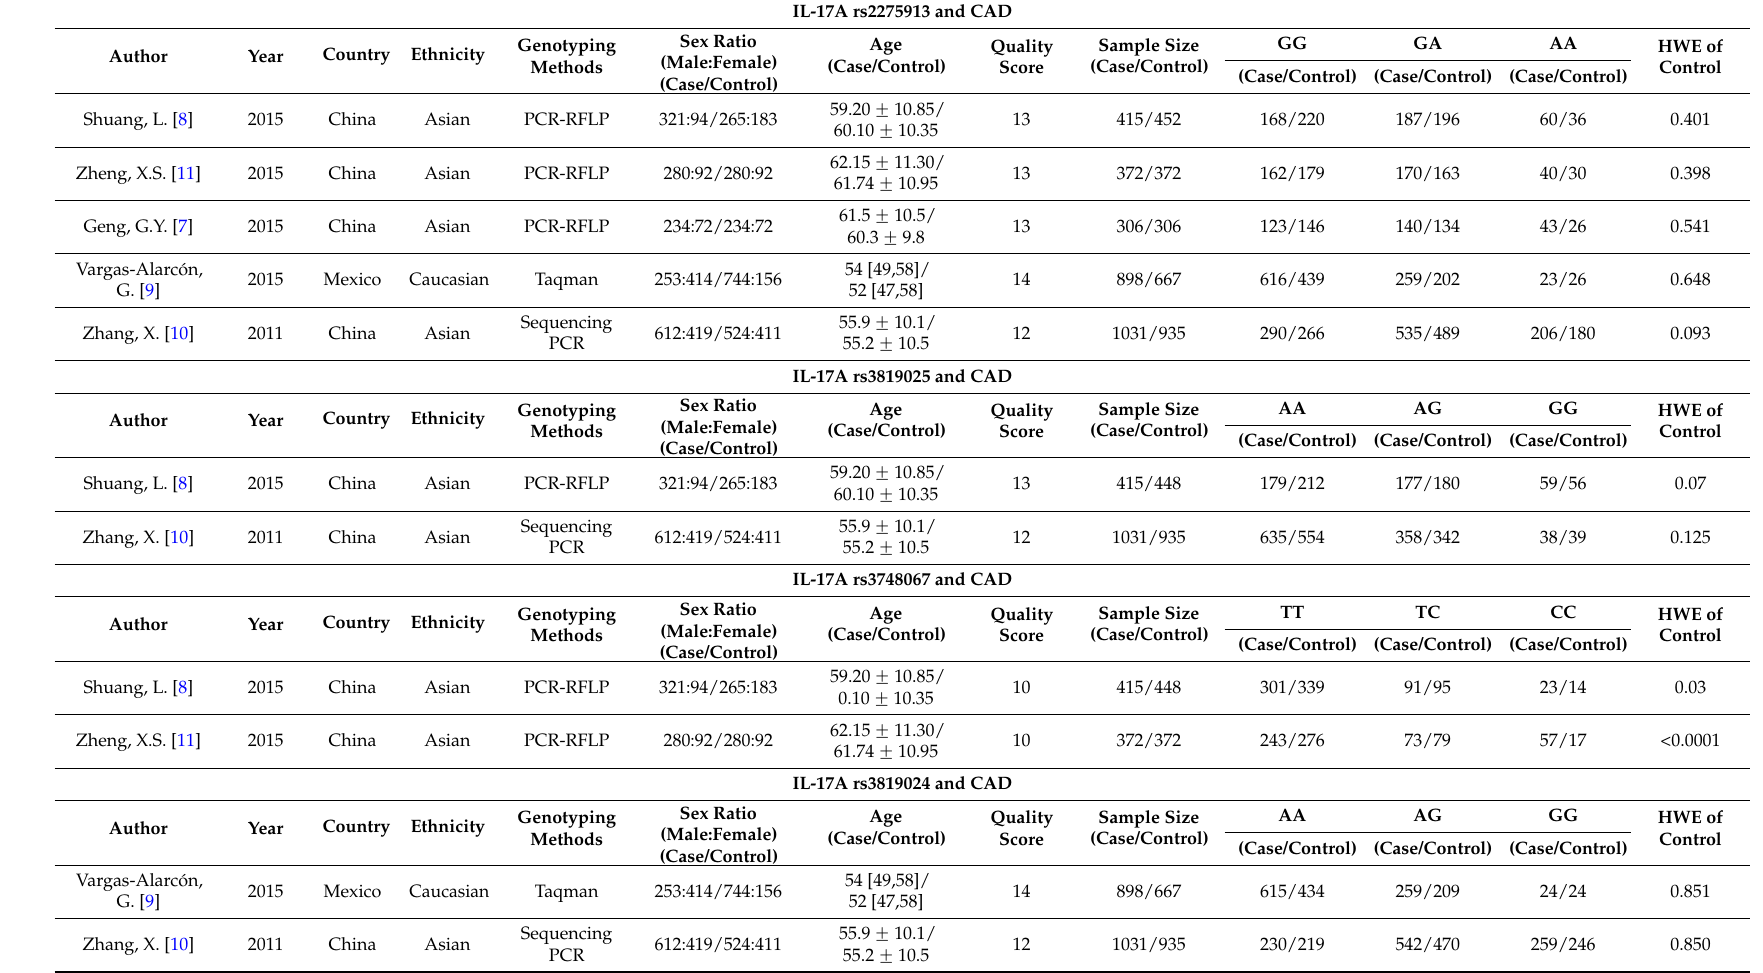
Table 1. Characteristics of eligible studies included in the meta-analysis. IL-17A rs2275913 and